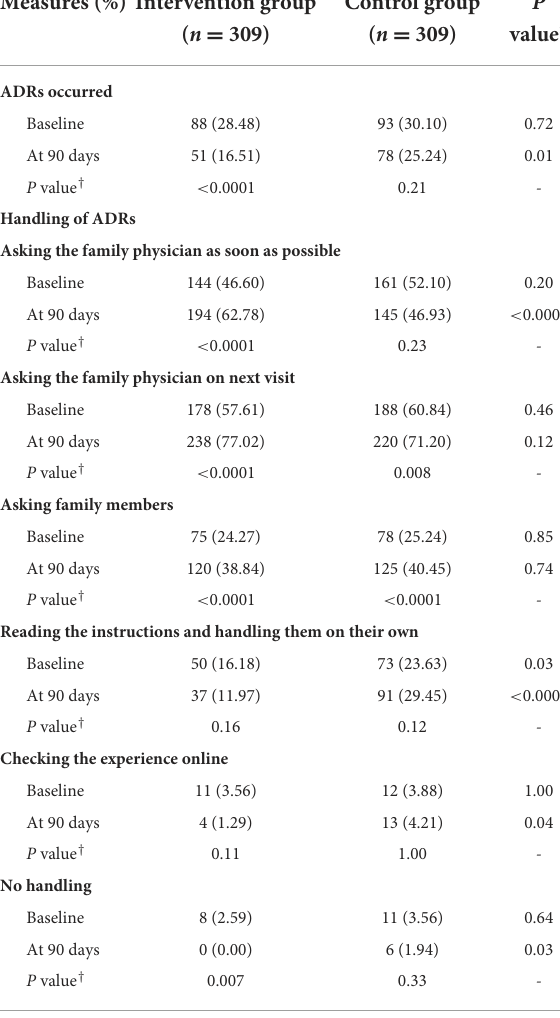
TABLE 5 Occurrence and handing of adverse drug reactions (ADR) of elderly patients with